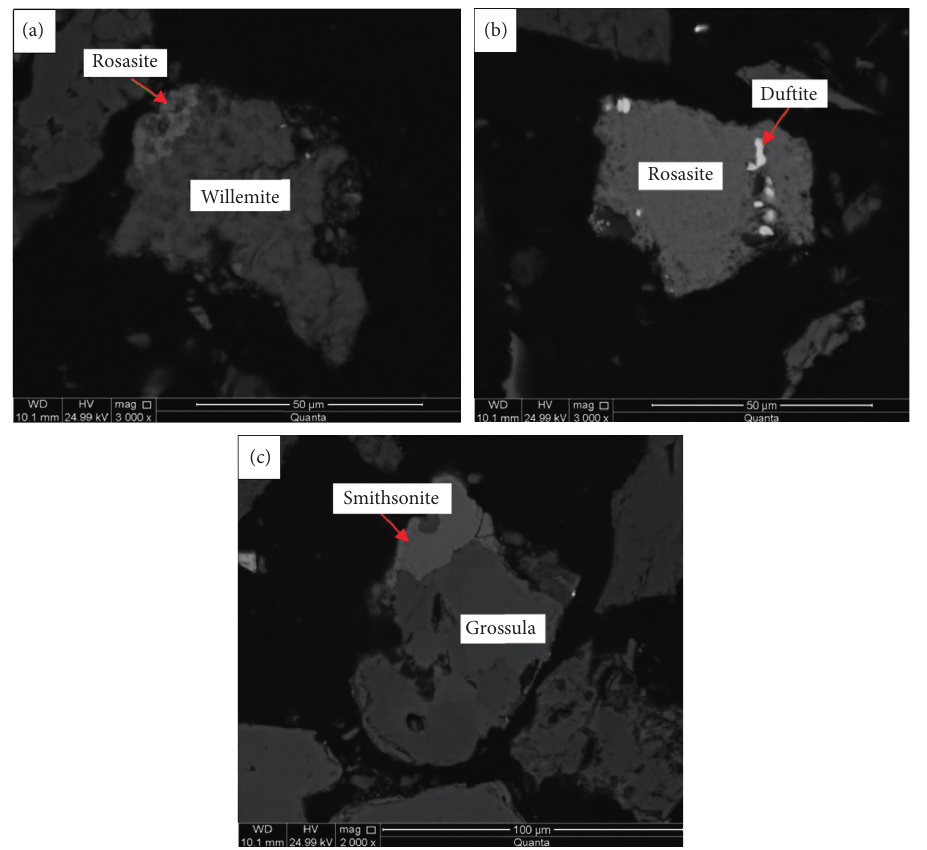
Figure 10: Embedded characteristics of rosasite and